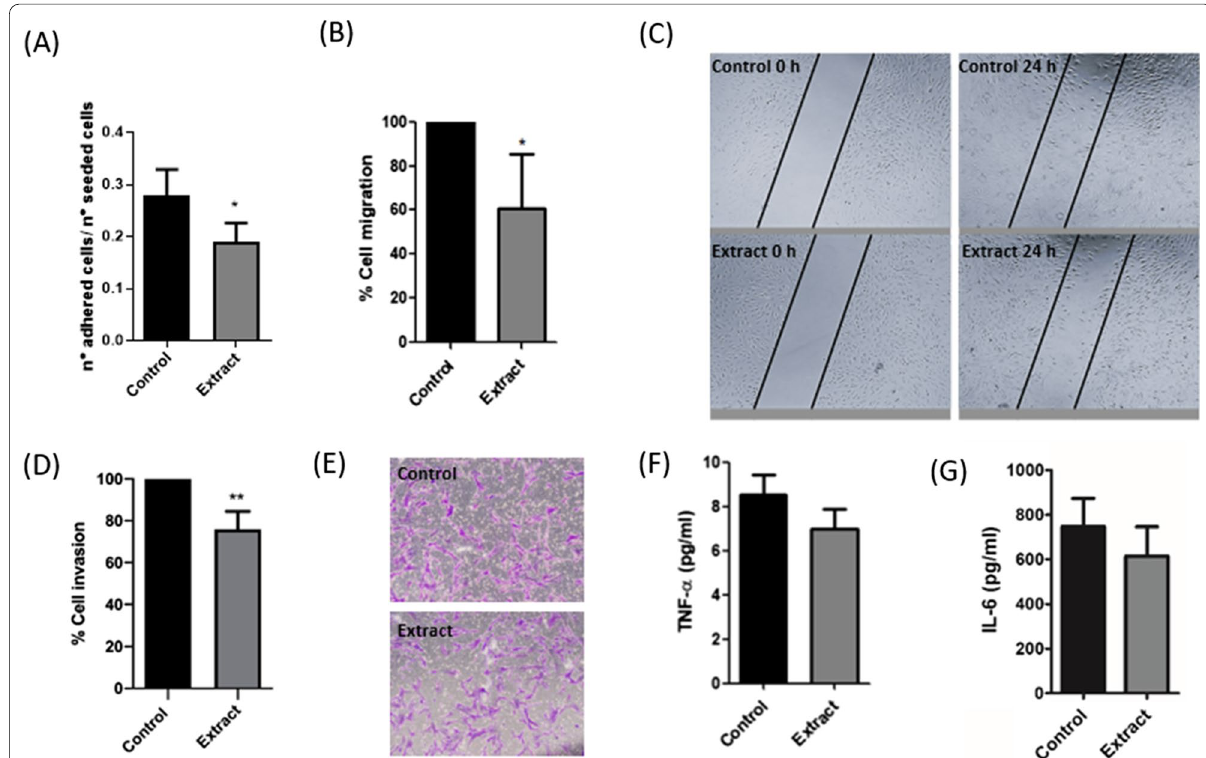
Fig. 4 F. hepatica extract reduced the adherence efficiency, the migratory, and invasion potentials of FLS. A Adherence capacity of FLS was analyzed after 6 h of F. hepatica extract incubation (100 µg/mL) (n 4). B Migratory potential of FLS after wound healing (n 3). C Representative = = microscopy images of FLS migration assay. D Invasive capacity of FLS was evaluated by matrigel assay (n 3). E Representative images of stained = cells that invaded through matrigel invasion chambers. F TNF-α secretion by FLS after INF-© stimulation (n 3) G IL-6 secretion by FLS after INF-γ = stimulation (n 3). Original magnification: 20 . T Test; Data are expressed as mean SD; p < = × ±